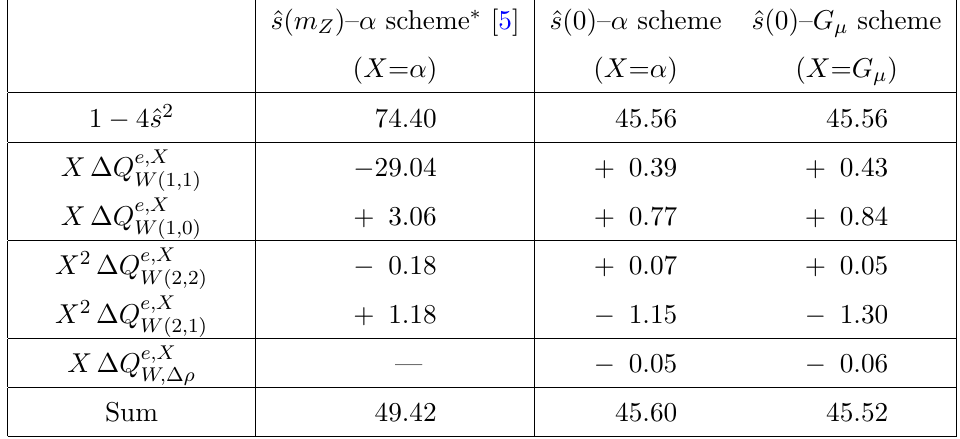
W ( L,n f ) closed fermion f